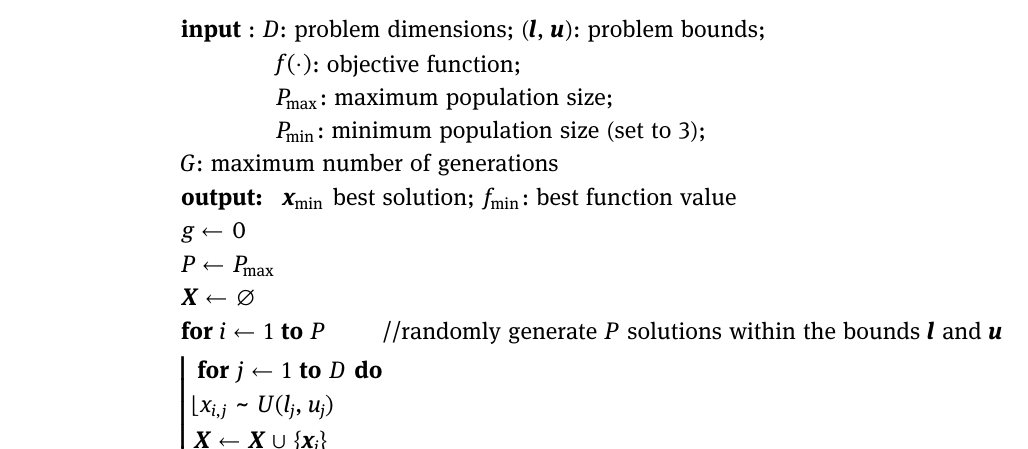
Algorithm 2: The Jaya2